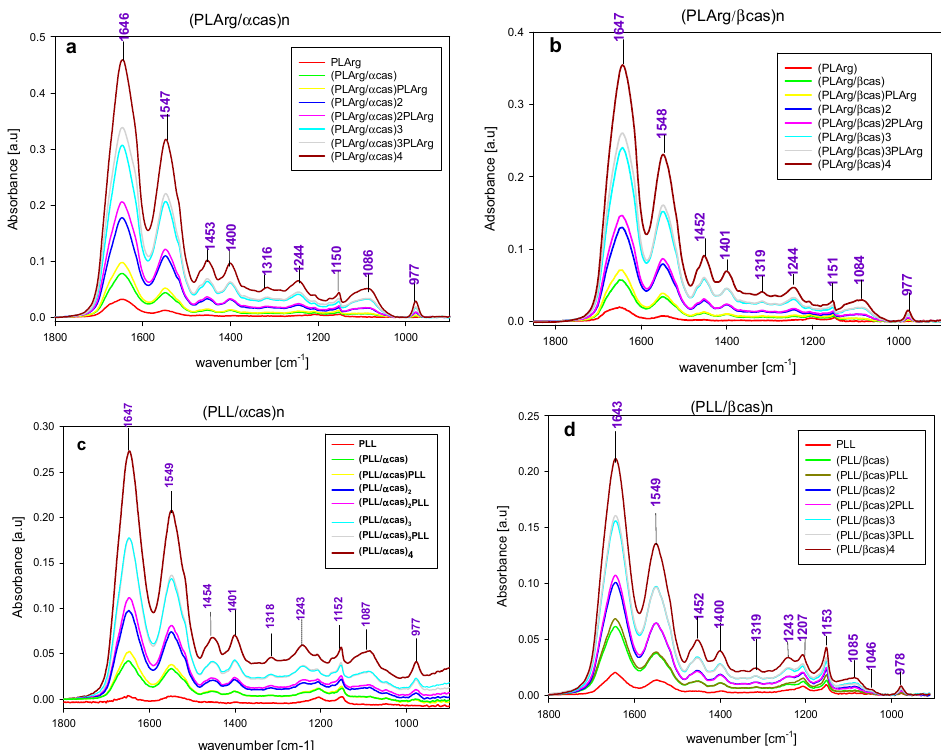
Figure 5. FTIR-ATR spectra of (PLArg / α -cas) n , (PLArg / β -cas) n —( a , b ) and (PLL / α -cas) n and (PLL / β -cas) n —( c , d ) taken after adsorption of the consecutive layer of polyelectrolyte or casein. Numbers denote positions of the maxima for the four bilayers films.